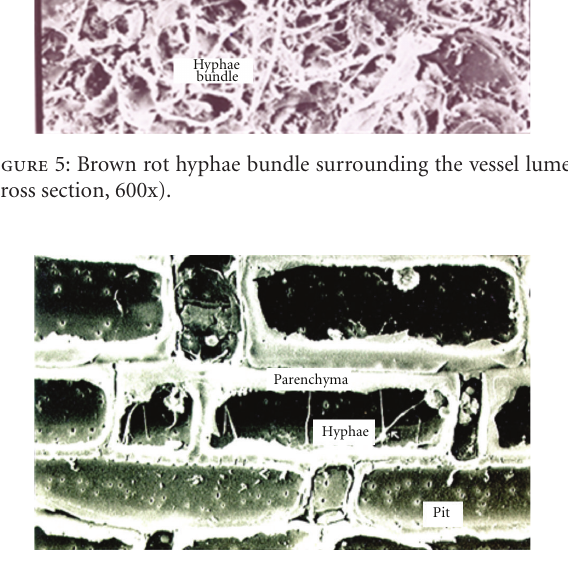
Figure 6: Brown rot hyphae penetration in parenchyma cell through the pits (longitudinal section,